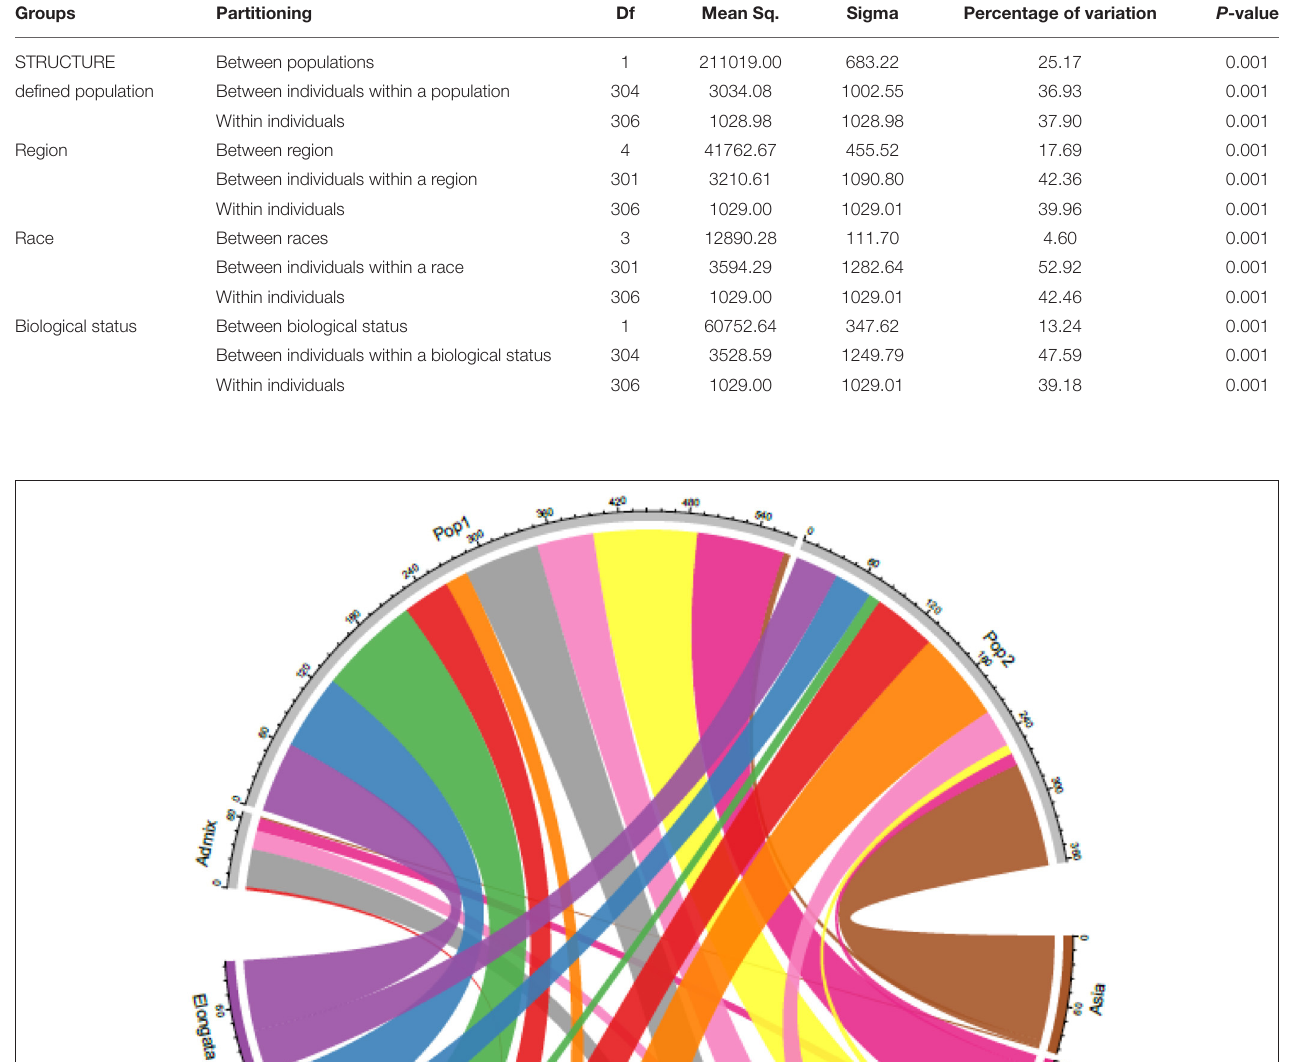
Frontiers in Plant Science |